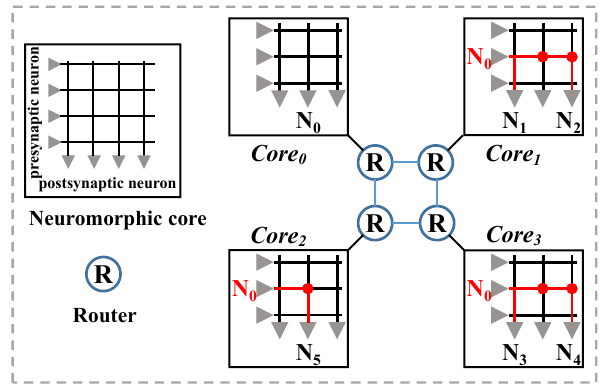
Figure 3. The neuron - to - core communication in neuromorphic